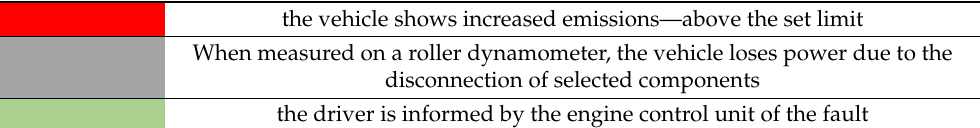
Table 8. Explanation of terms from Table 7